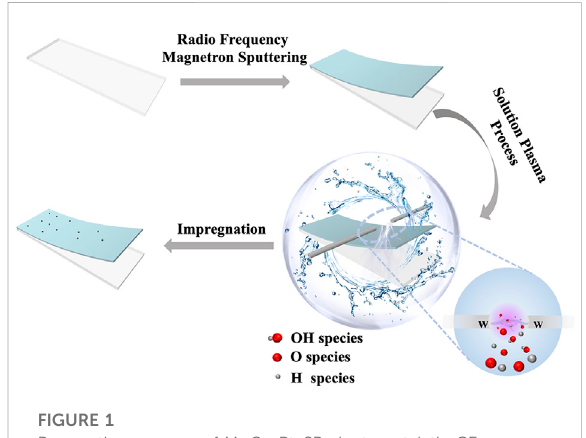
FIGURE 1 Preparation process of MoO x -Pt-SP electrocatalytic